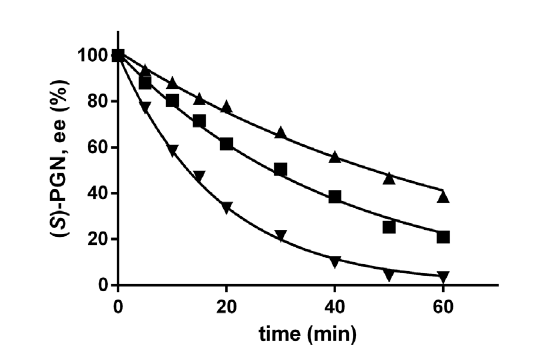
FIGURE 8 Spontaneous racemization of phenylglycinonitrile in NH 4